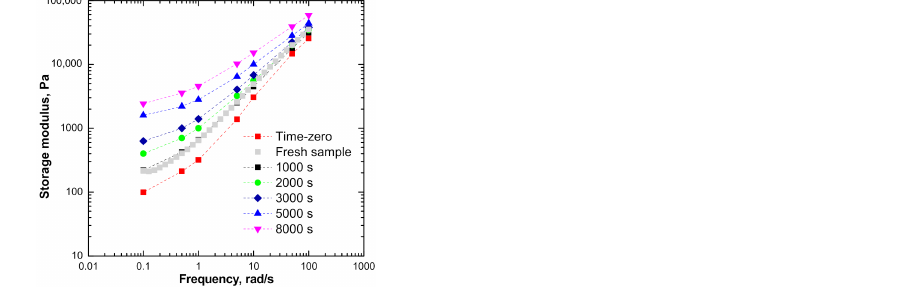
Figure 7. Isochronal storage modulus for ENR+SiO 2 , collected at different times during TRMS